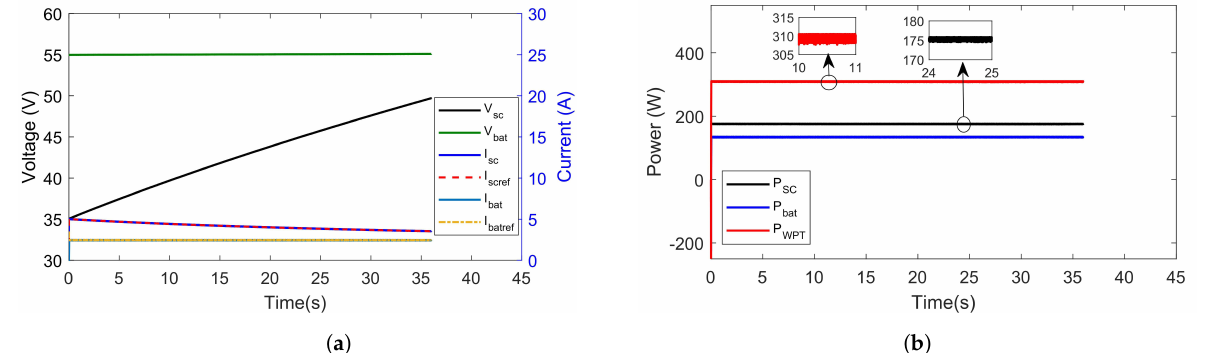
Figure 13. For V sci = 35 V ( a ) V sc , I sc , V bat , I bat , ( b ) P sc , P bat , P wpt . Table 4. Turning Power ( P t ) for different V sci .